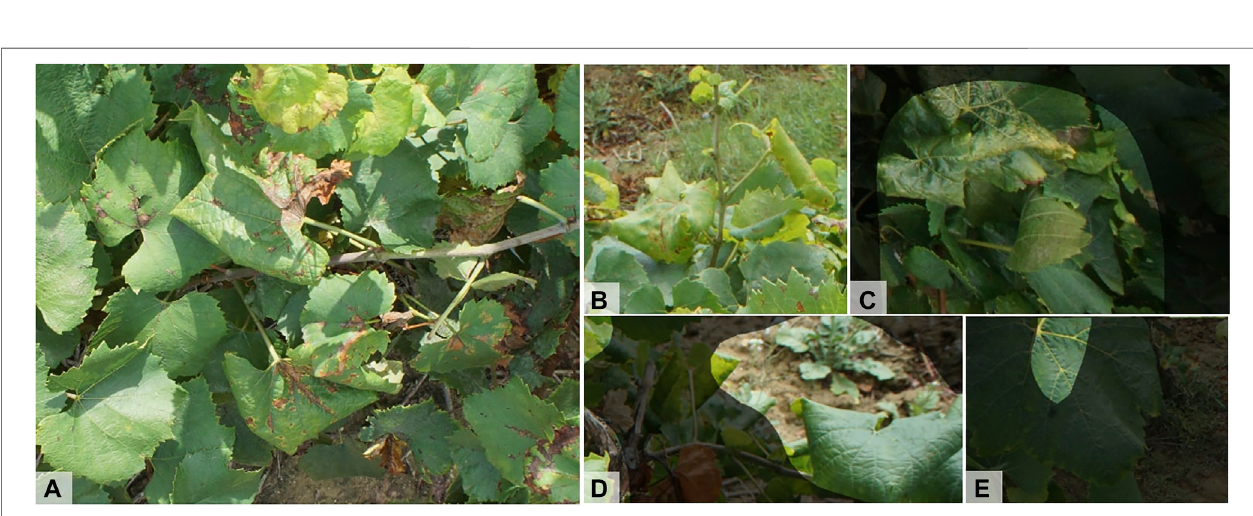
FIGURE 6 | Examples of false predictions from the Pers. Chardonnay Test dataset. (A,B) Undetected Flavescence dorée (FD) symptoms, (C,D) Over-detection close to FD symptomatic areas, (E) : Visually unexplainable false FD